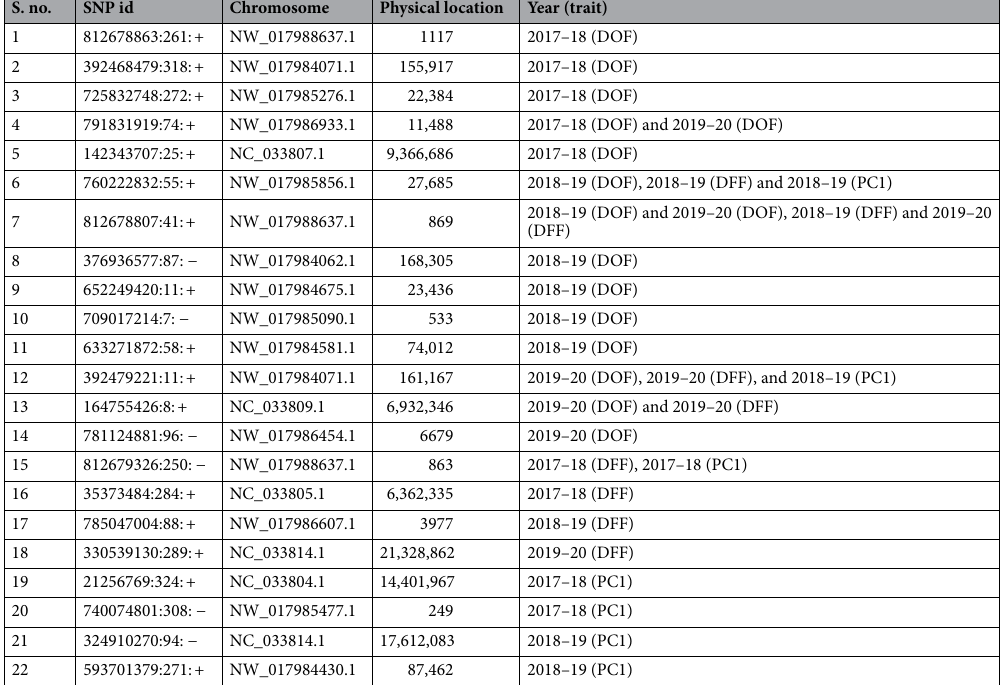
Table 3. List of selected SNPs further used for annotation analysis.